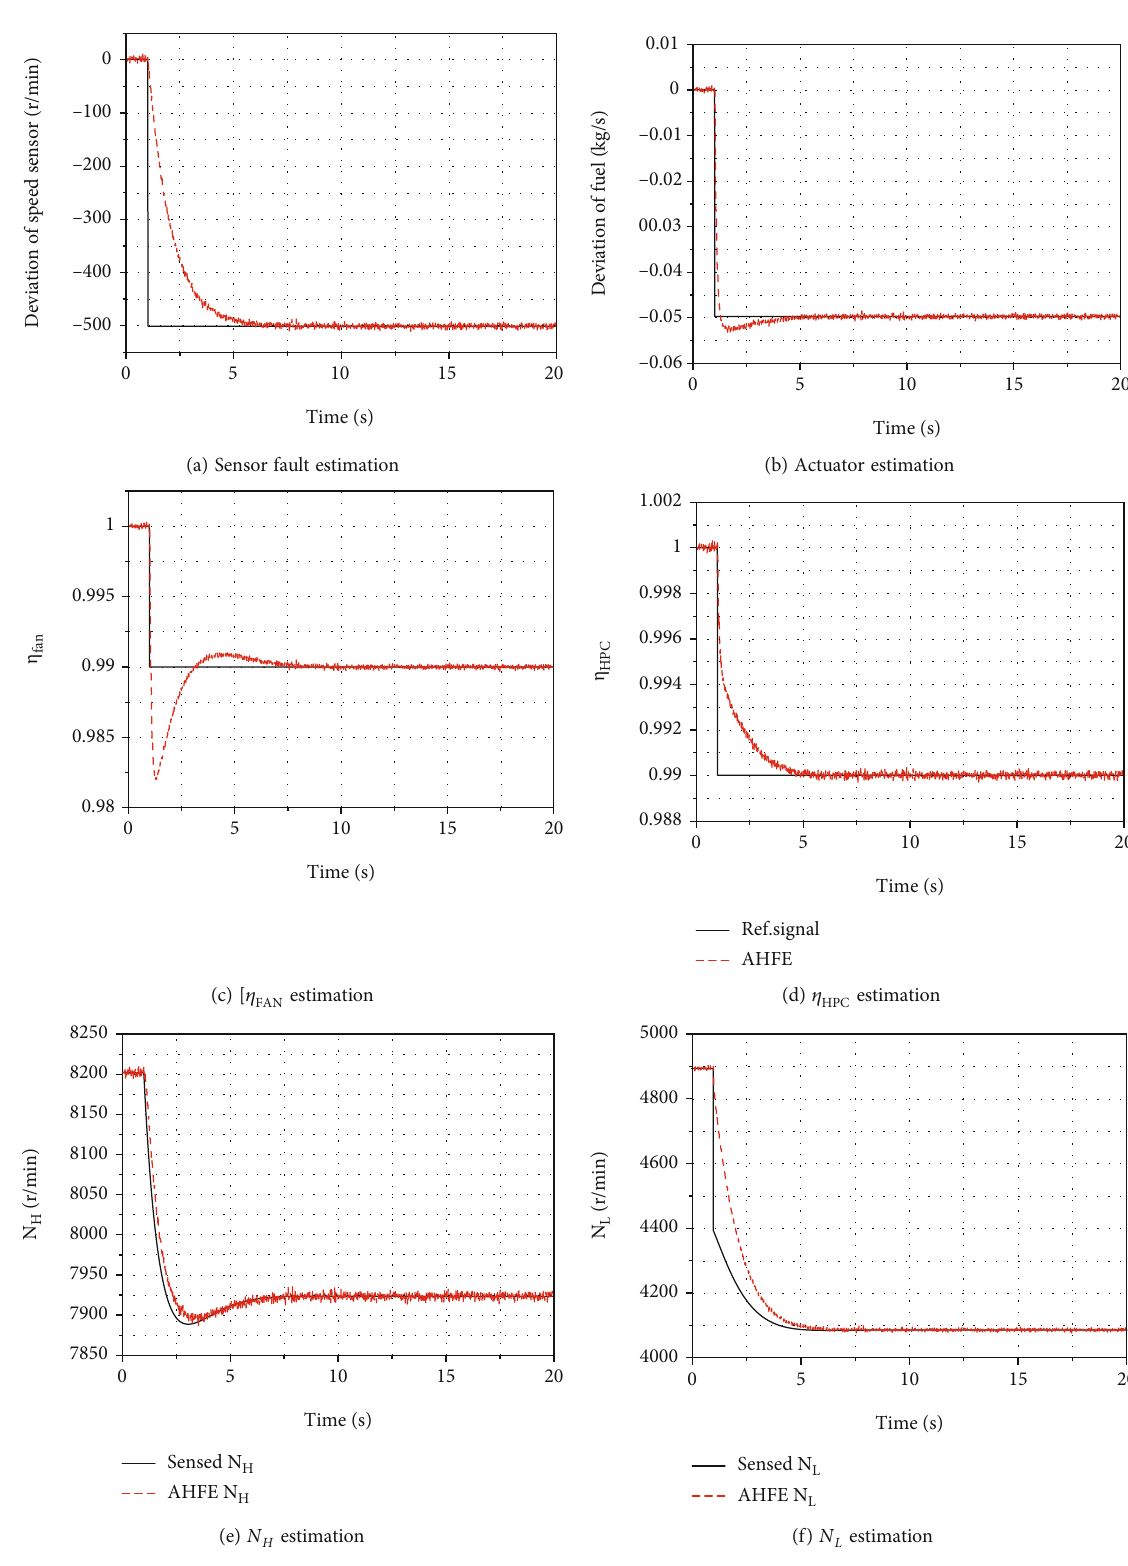
Figure 15: Estimation result based on the improved